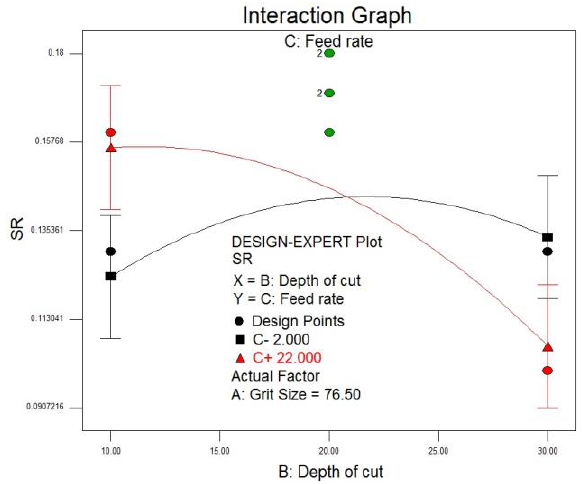
Figure 10: The interaction effect of feed rate and depth of cut.